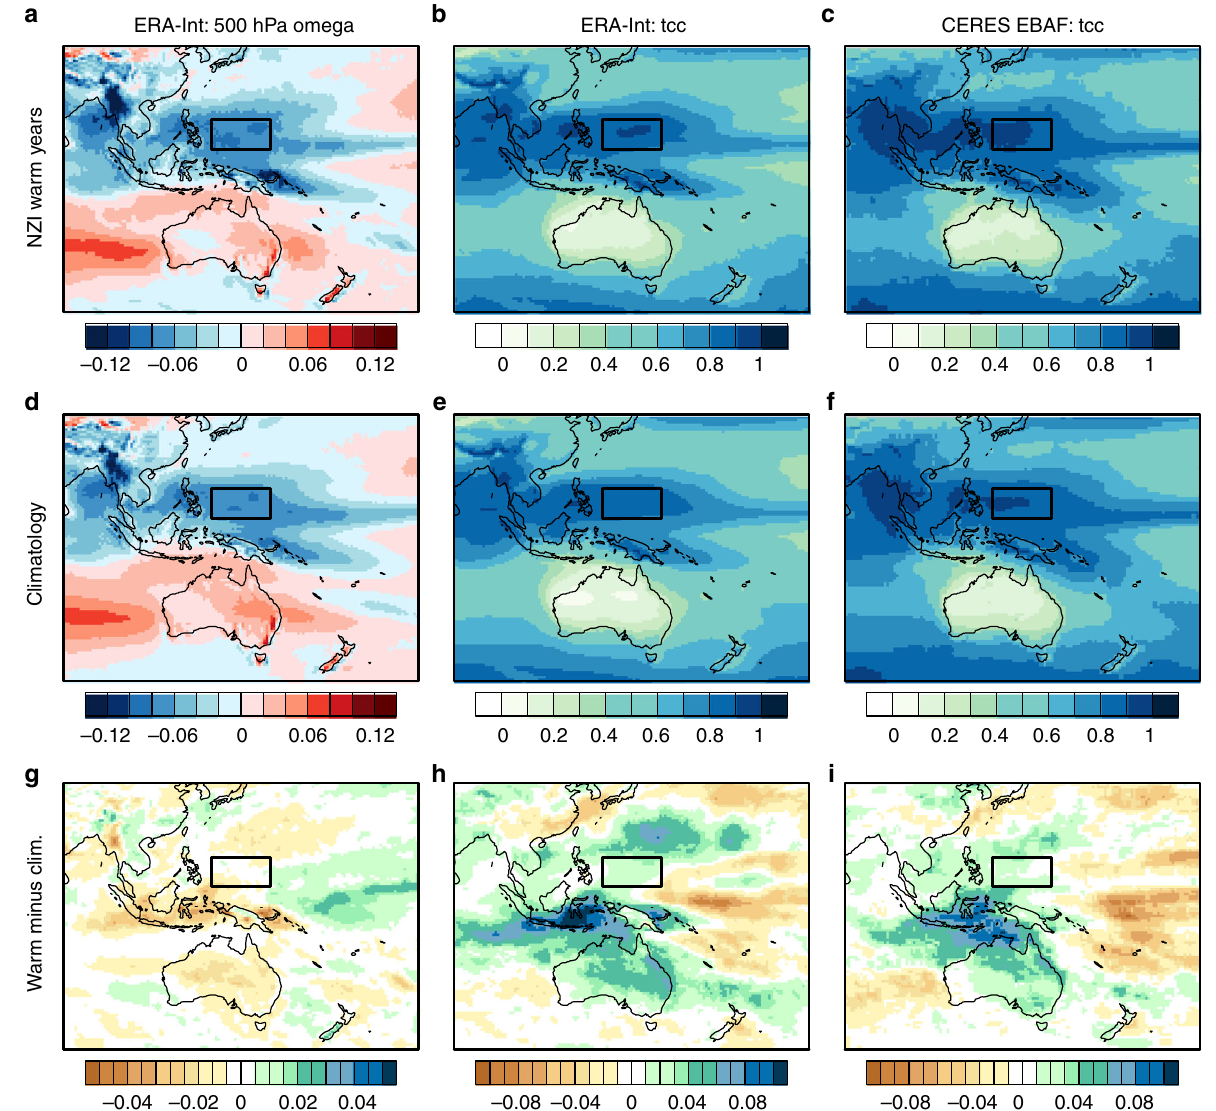
Fig. 2 July – September ERA-Interim composites during the 5 warmest NZI years (based on ranked July – September SST anomalies) compared to climatology (1979 – 2016). a , d , g 500-hPa omega velocity (Pa/s, negative values indicate ascending motion); b , e , h total cloud cover (tcc). c , f , i are tcc from CERES EBAF satellite data (years 2000 – 2016). Due to the CERES EBAF data beginning in 2000, one less year was used to construct the composite in c . Almost identical results were found when NZI warm years and associated composites were instead calculated for September – November (not shown). The EPH region is indicated by a black